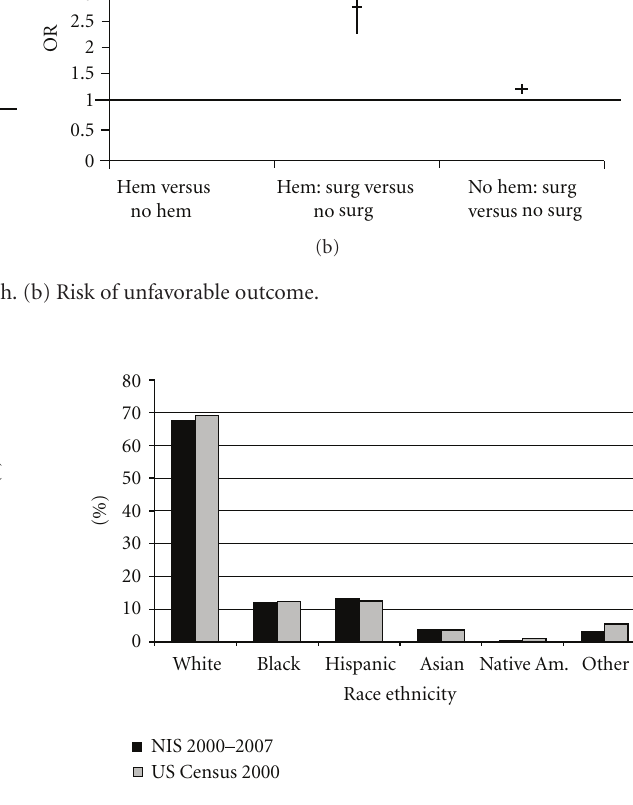
Figure 5: Racial and ethnic